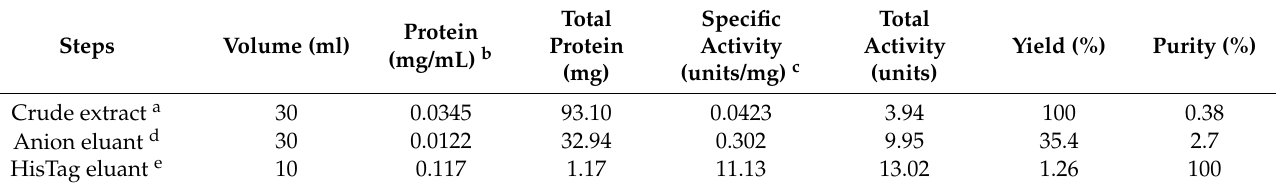
Table 3. Purification table for